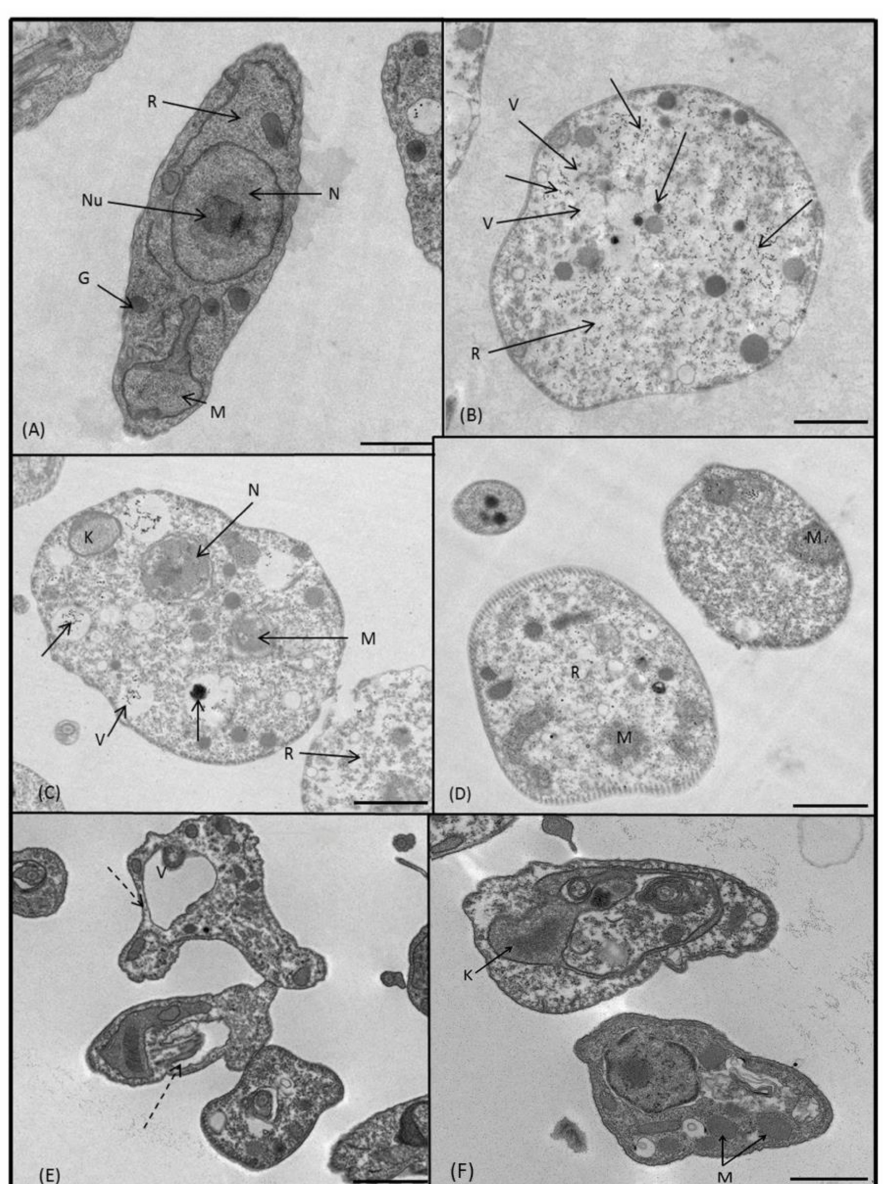
Figure 7. Ultrastructural images of L. braziliensis promastigotes treated for 72 h at IC 25 concentrations with: ( A ) untreated control, ( B ) 3 , ( C ) 7 , ( D ) 8 , ( E , F ) 10 . (N) nucleus, (Nu) nucleolus, (R) ribosomes, (K) kinetoplast, (M) mitochondrion, (G) glycosome, (V) vacuole, (arrow) electron-dense precipitates of unassimilated compounds, (dashed arrow) irregular morphologies. In all cases scale bar corresponds to 1 µ